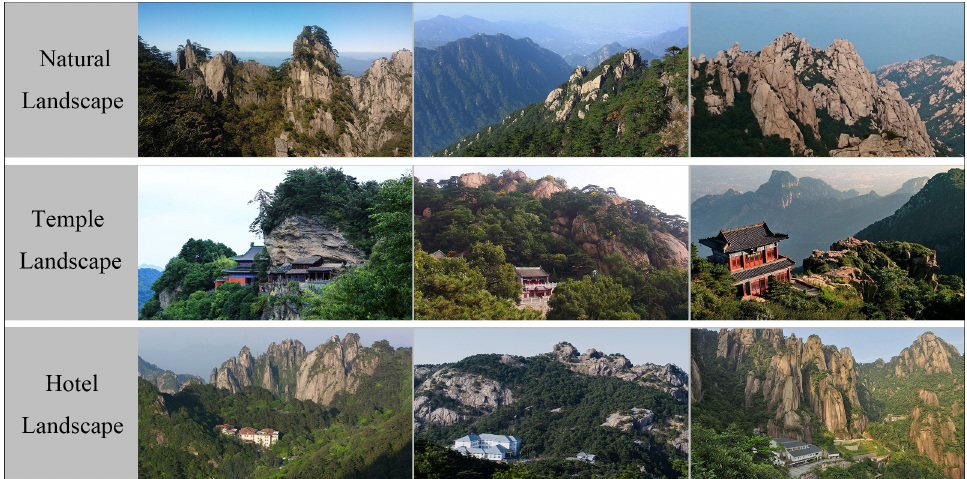
Figure 2. Landscape images. Images were selected from the official websites of tourism bureaus or scenic spot committees, including the Management Committee of Huangshan National Park (http://hsgwh.huangshan.gov.cn/) (accessed on 26 February 2018), the Management Committee of Scenic Spots and Historic Sites of Taishan (http://tsgw.taian.gov.cn/) (accessed on 26 February 2018), the Wudang Mountains Tourism Portal (http://ly.wudangshan.gov.cn/) (accessed on 26 February 2018), the Mount Laoshan tourism Portal (http://www.qdlaoshan.cn/) (accessed on 26 February 2018), and the Committee of Mount Jiuhua (http://www.jiuhuashan.gov.cn/) (accessed